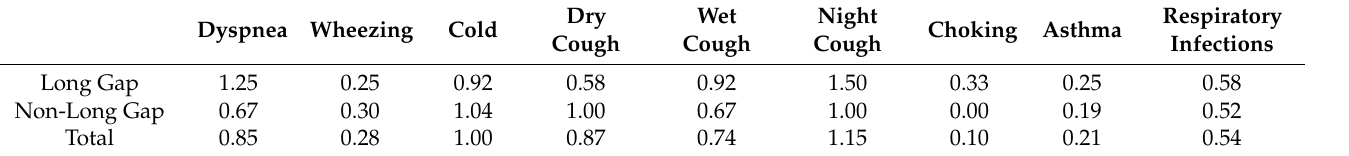
Table 4. Score of respiratory symptoms.